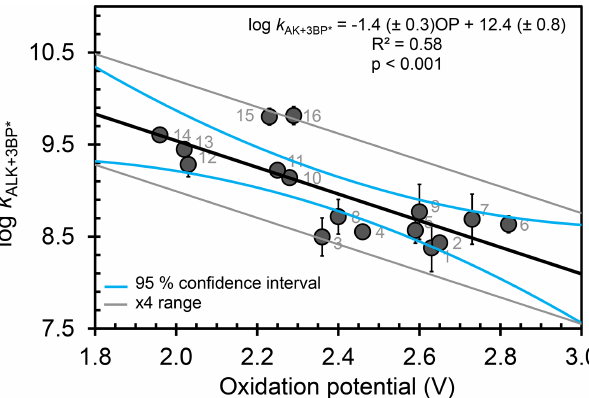
Figure 3. Correlation between measured bimolecular rate con- stants for alkenes with the triplet excited state of benzophenone ( k ALK + 3BP ∗ ) and the computed one-electron oxidation potentials of the alkenes. Numbers on each point represent the alkene num- bers in Table 1. Blue lines represent 95% confidence intervals of the regression prediction. The gray lines bound the region that is within a factor of 4 of the regression prediction; all but one of the alkene values fall within this. Methyl jasmonate (17) is not included in this figure due to computational challenges in calculating its OP (see Table